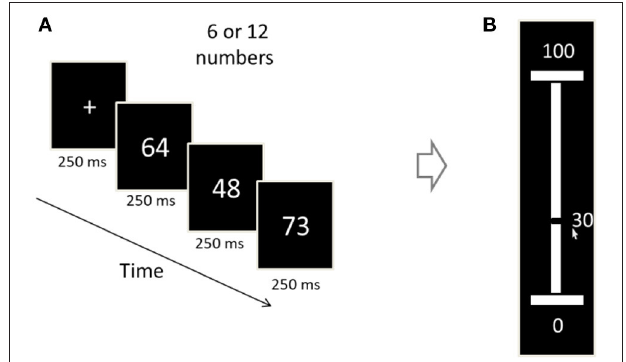
FIGURE 3 | Illustration of an experimental trial (Exp. 1–2). (A) Each trial begins with a 250ms fixation cross, after which a sequence of two-digit numbers is presented (250 ms/numeral). The sequence-length is 6 or 12 (randomized between trials). (B) The participants were asked to convey the sequence’s average, by vertically sliding a mouse-controlled bar set on a number ruler (white bar) between 1 and 100. The number corresponding to the bar’s location is being dynamically displayed (30 in the